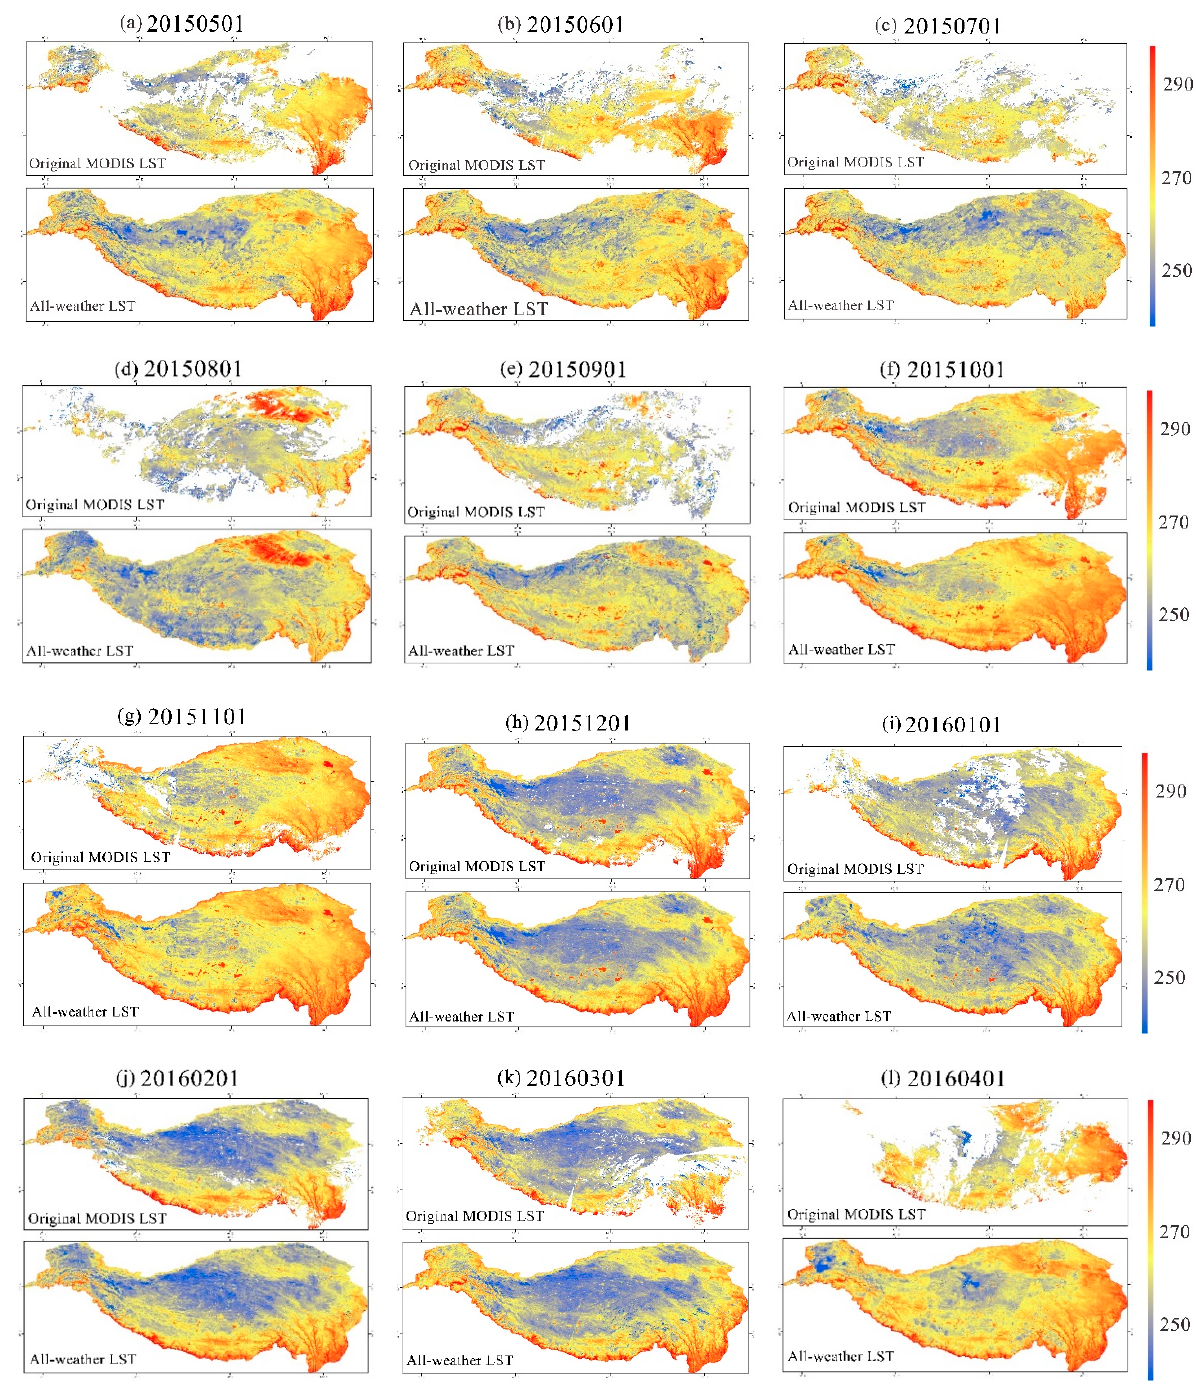
Figure 8. Monthly variation of the original MODIS LST and the all-weather 1 km LST of the Tibetan Plateau from May